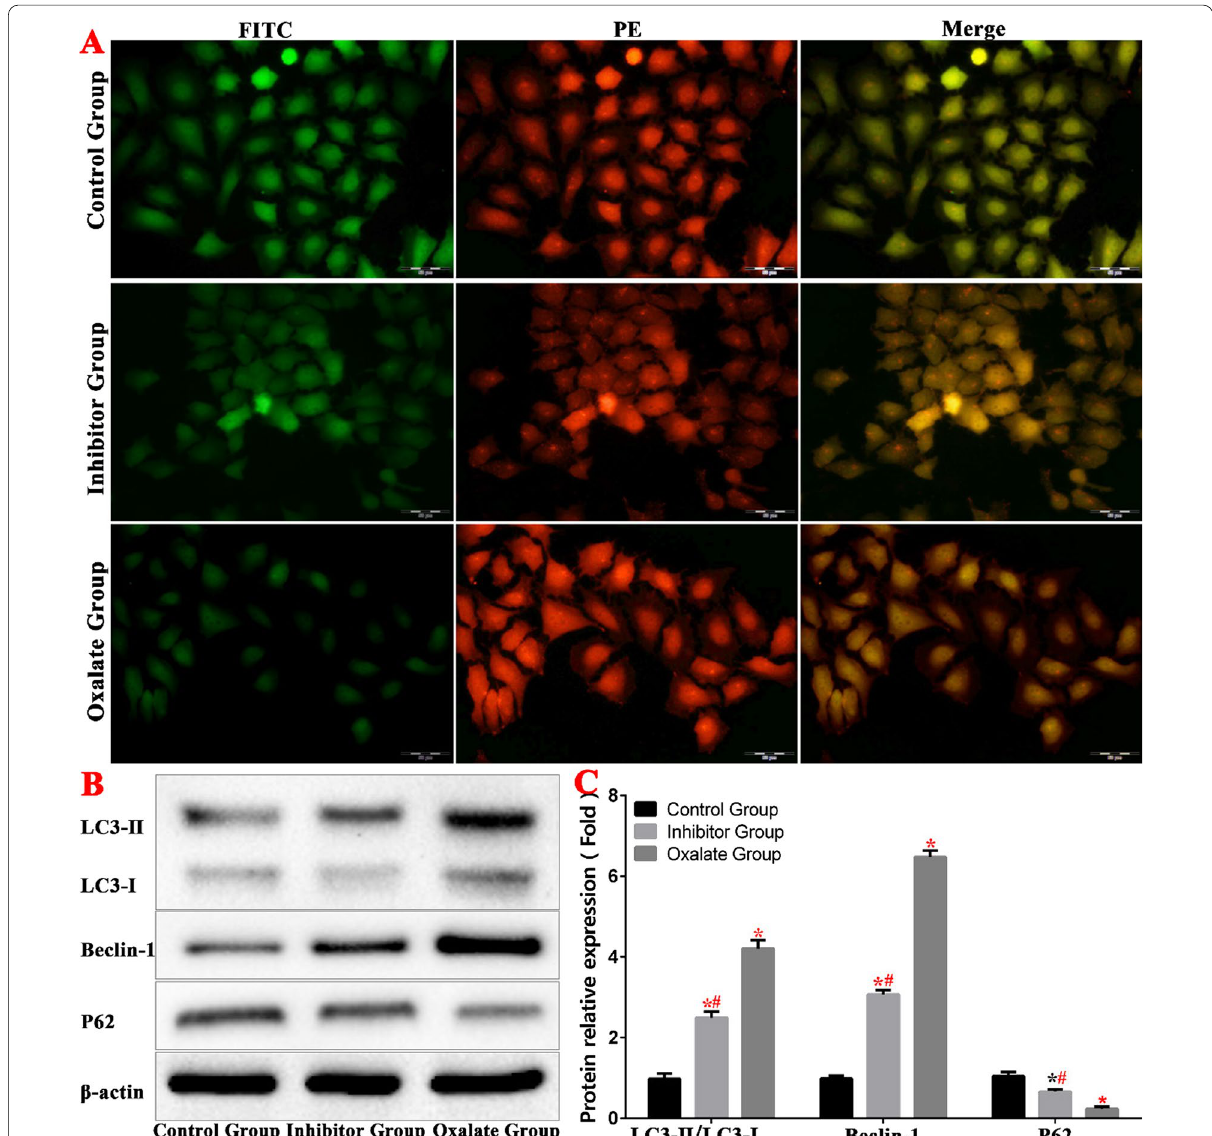
Fig. 4 Oxalate-induced autophagy in HK-2 cells. A Autophagy level of each group of autophagy lentivirus. B , C Western blot was used to detect the expression of autophagy-related protein in each group.(*compared with normal Control group, P < 0.05.* (Red) Compared with control group, P < 0.01. #(Red) Compared with oxalate group, P <